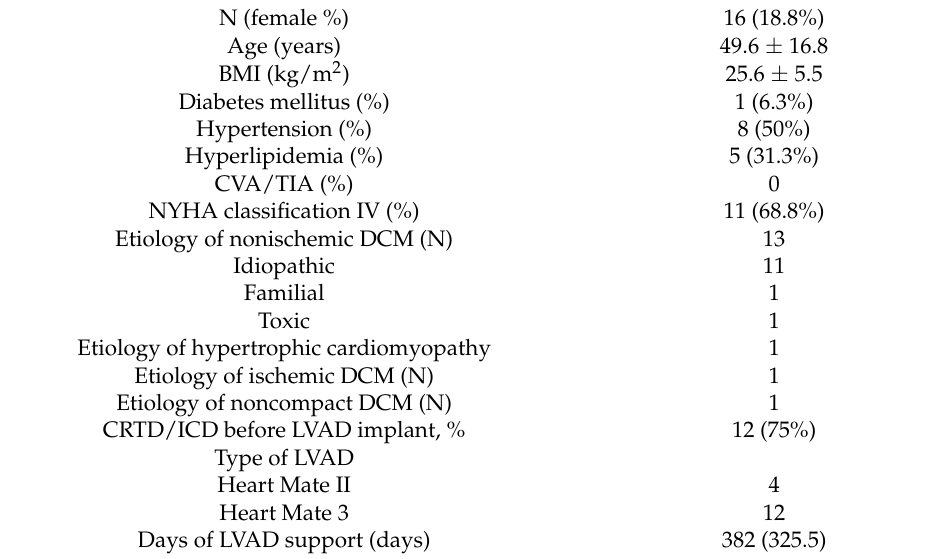
Table 2. Demographics of the patients selected for mRNA/miRNA